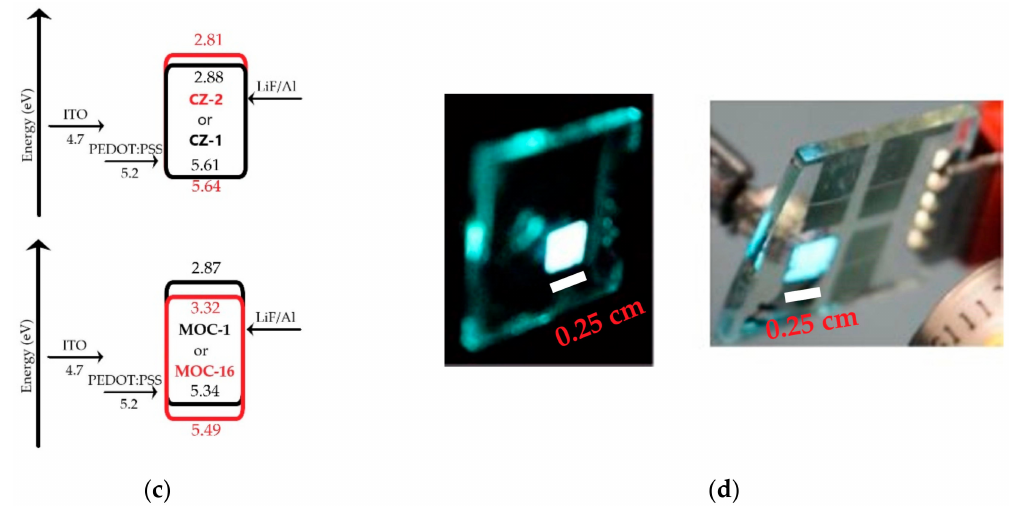
Figure 5. J-V curves and luminances of OLEDs based on ( a ) carbazole derivatives with the configuration ITO/PEDOT:PSS (30–40 nm)/Carbazole derivative (70–80 nm)/LiF (1 nm)/Al (150 nm); here are shown the best values, for deviations/error bars see Figure S8 (SI); ( b ) TPD derivatives with the configuration